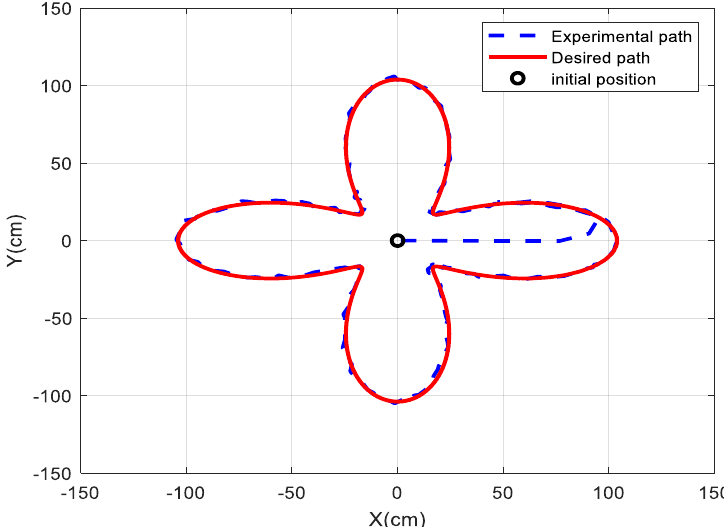
Figure 5. Experimental result of CS-fuzzy real-time trajectory tracking.